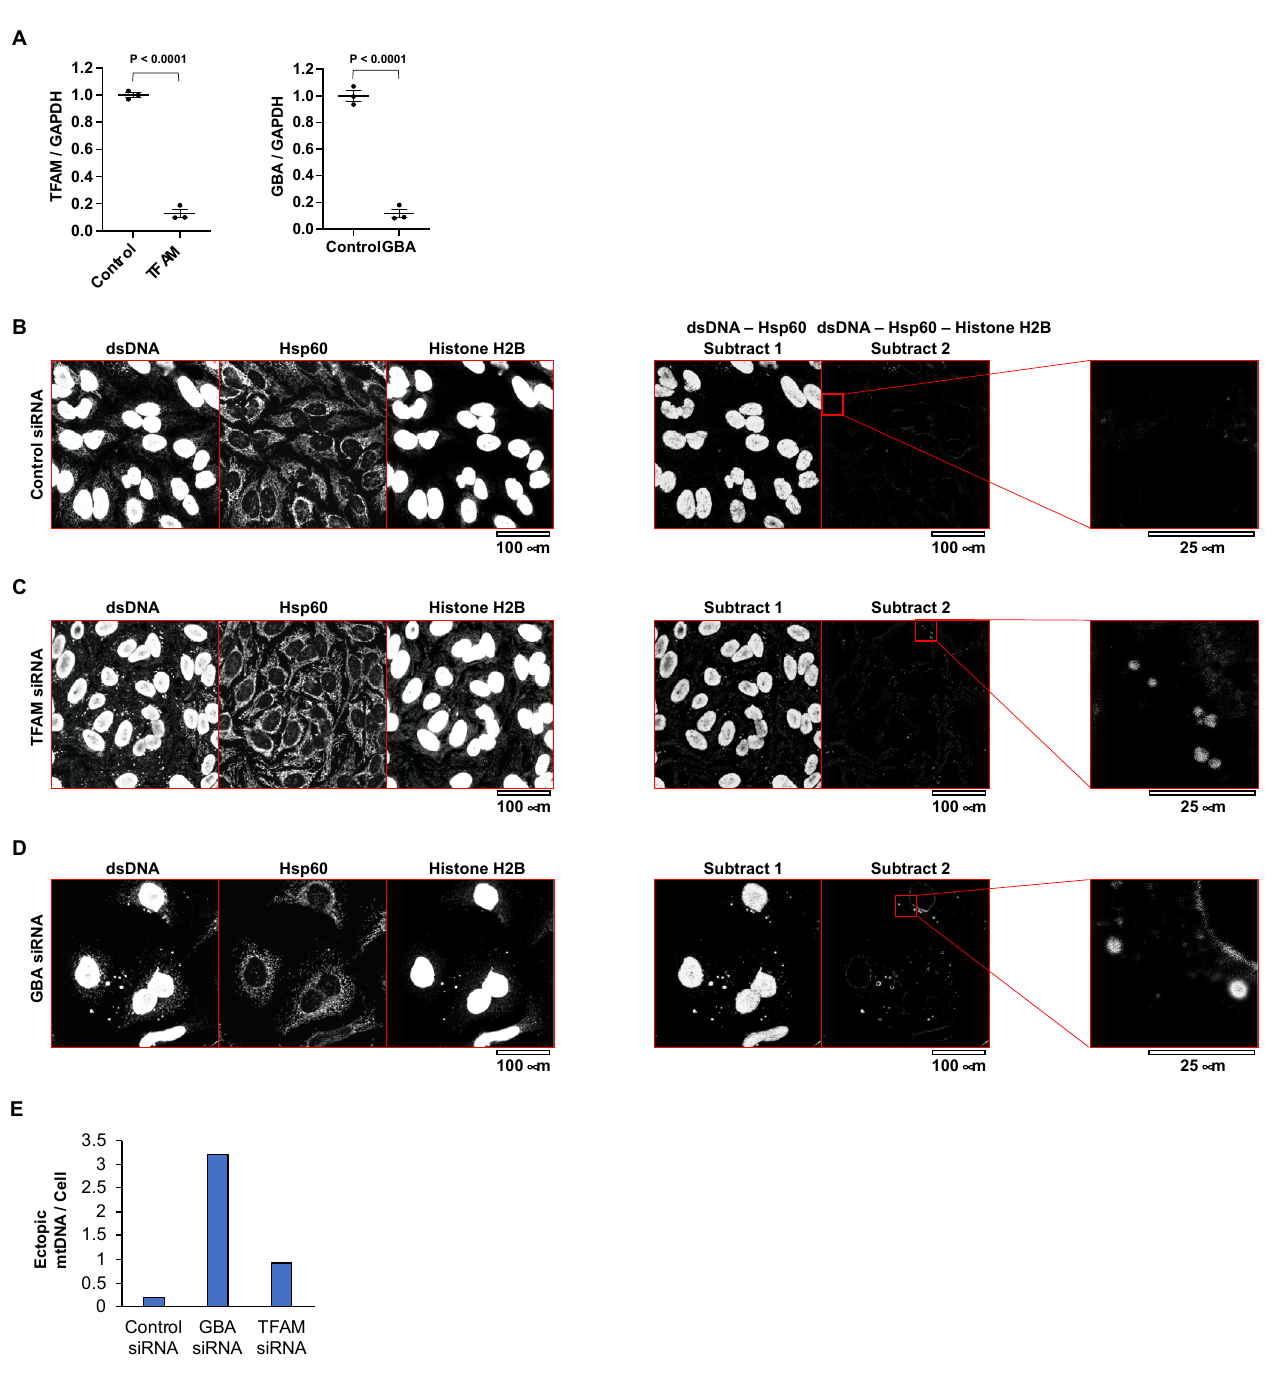
Figure 1. Loss of TFAM or GBA protein leads to cytosolic leakage of mitochondrial DNA. ( A ) qPCR of TFAM and GBA mRNA 3 days after siRNA transfection. ( B ) Immunostaining for dsDNA, histone H2B, and Hsp60 in HeLa cells transfected with control siRNA (day 3). Subtract-1 image shows the subtraction of the Hsp60 image from the dsDNA image. Subtract-2 image shows the subtraction of the Hsp60 image and histone-H2B image from the dsDNA image. The image on the far right is an enlargement of the red square in the Subtract-2 image. ( C ) Knockdown of TFAM expression with siRNAs in HeLa cells. Immunostaining for dsDNA, histone H2B, and Hsp60 in HeLa cells transfected with TFAM siRNA (day 3). Subtract-1 image shows the subtraction of the Hsp60 image from the dsDNA image. Subtract-2 image shows the subtraction of the Hsp60 image and istone-H2B image from the dsDNA image. The image on the far right is an enlargement of the red square in the Subtract-2 image. ( D ) Knockdown of GBA expression with siRNAs in HeLa cells.